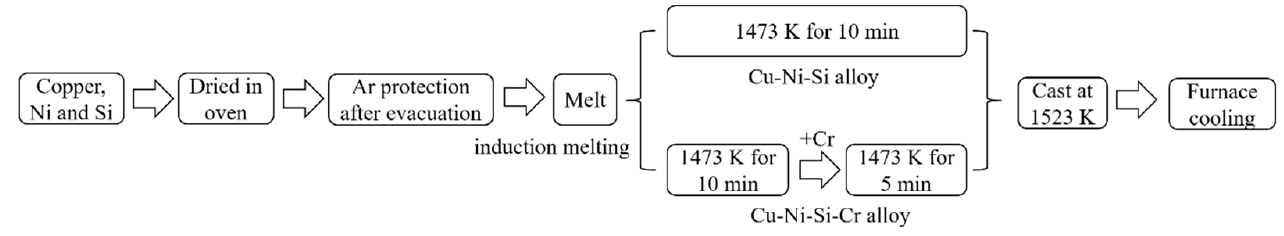
Figure 1. Cast process of the CuNiSi alloys with different Cr contents. Table 1. Chemical compositions of the designed CuNiSiCr alloys (in wt.%). Alloys Ni Si Cr Cu CuNiSi 1.917 CuNiSi-0.15Cr CuNiSi-0.30Cr CuNiSi-0.45Cr CuNiSi-0.90Cr